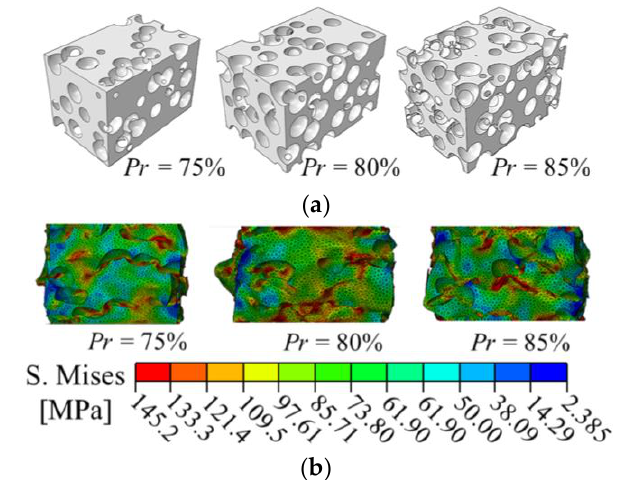
Figure 9. ( a ) FE models and ( b ) deformation configurations at compressive strain of 0.35.